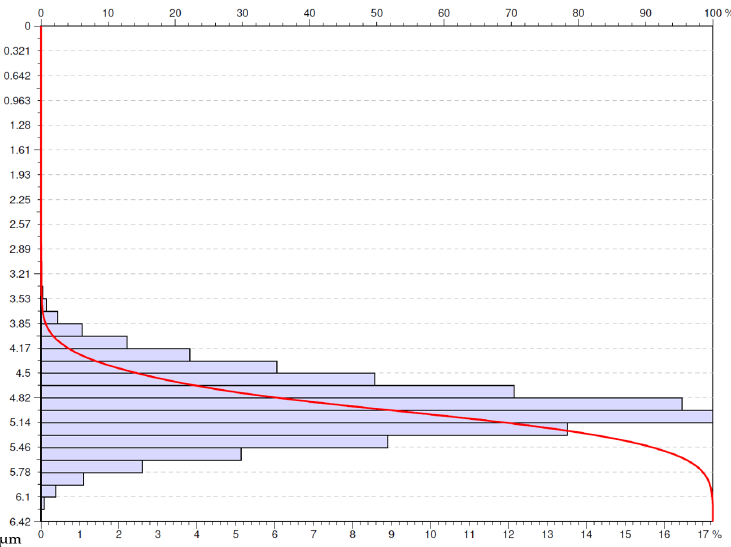
Figure 20. Abbott-Firestone curve after dry turning by Wiper insert with feed f = 0.05 mm/rev.